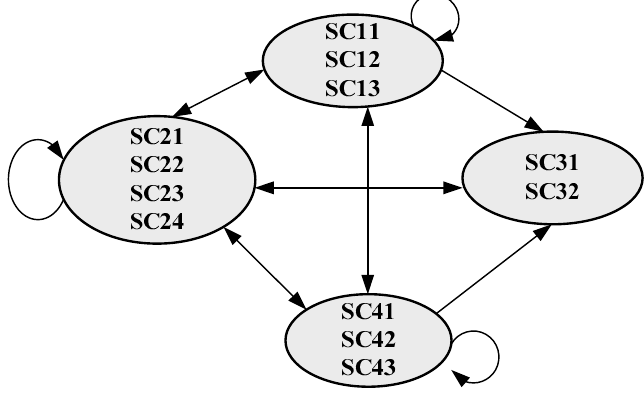
Figure 4. Partial network with sub-criteria.